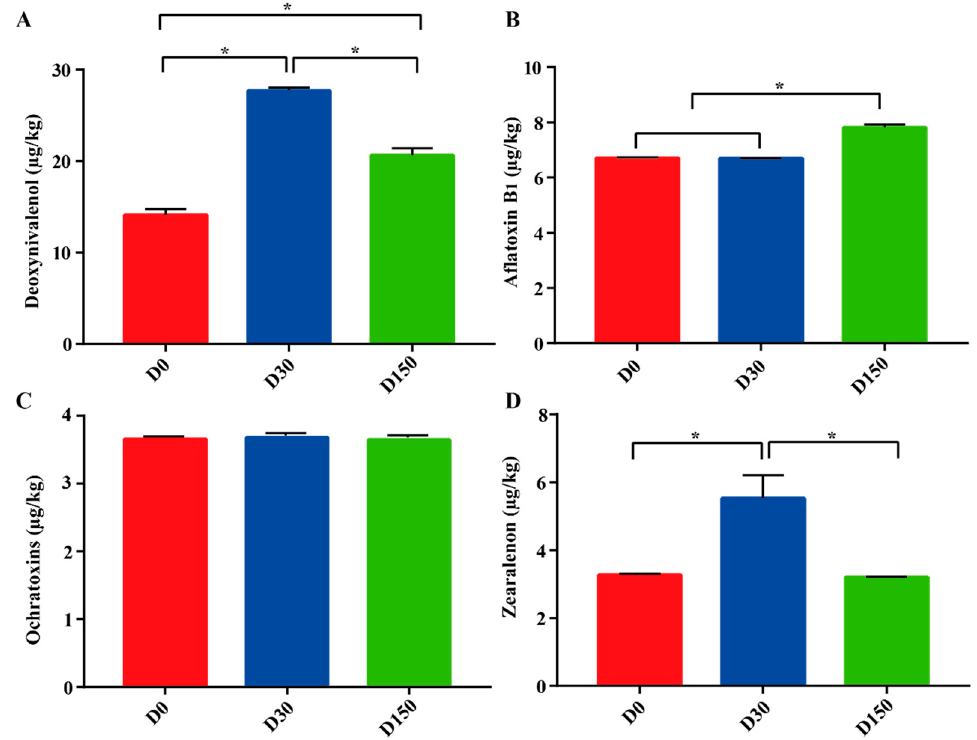
Figure 1. Mycotoxins across the three storage times (n = 6). ( A ) Deoxynivalenol. ( B ) Aflatoxin B1. ( C ) Ochratoxins A. ( D ) Zearalenone. D0, storage for 0 d; D30, storage for 30 d; D150, storage for 150 d. * Indicates significant difference among the three groups at p < 0.05 level.